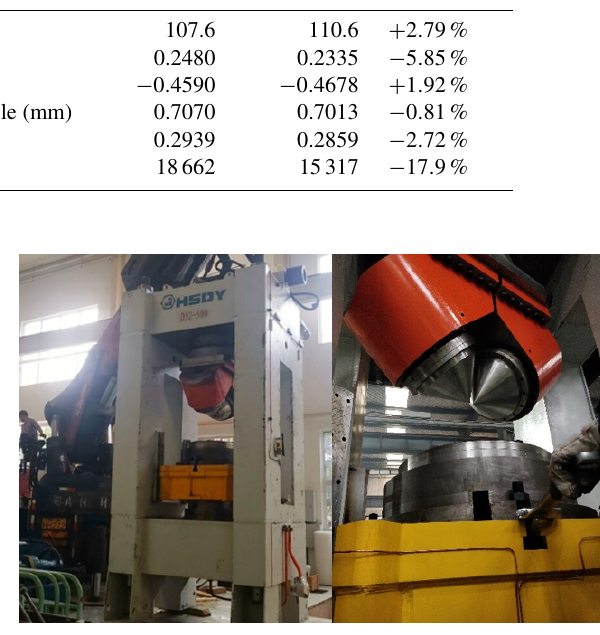
Figure 25. Double roll rotary forging machine